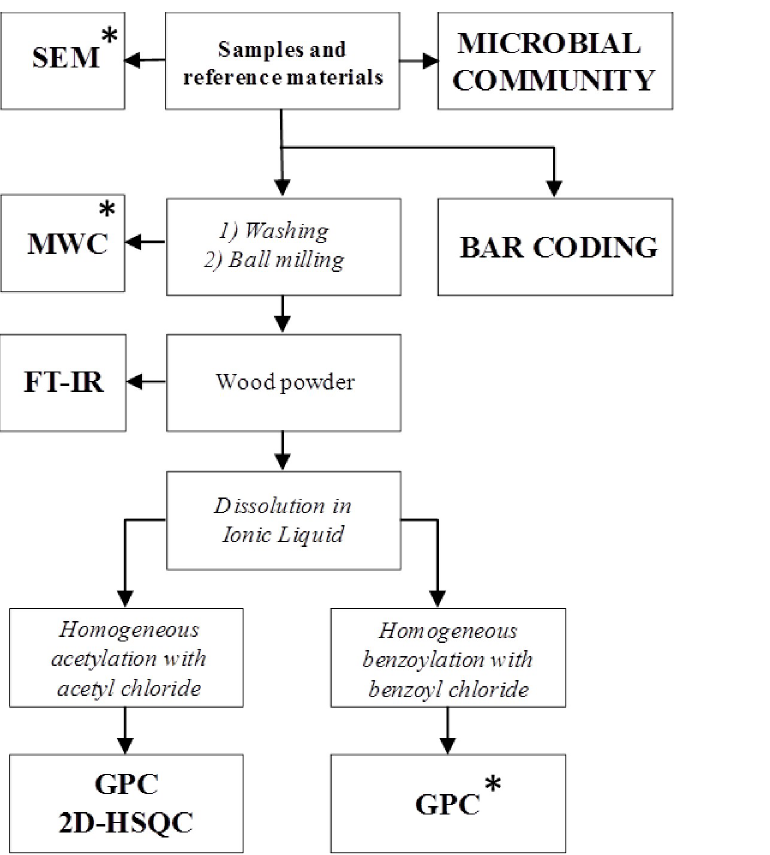
Fig 2. The integrated characterisation approach performed in this work and in [1] �